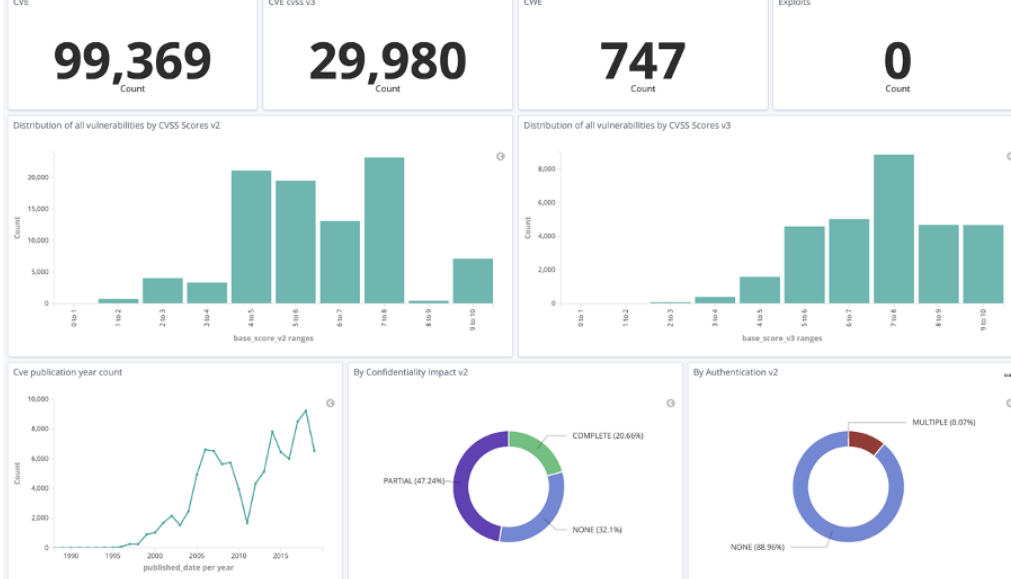
Figure 1. An example of data gathered by knowledge collector